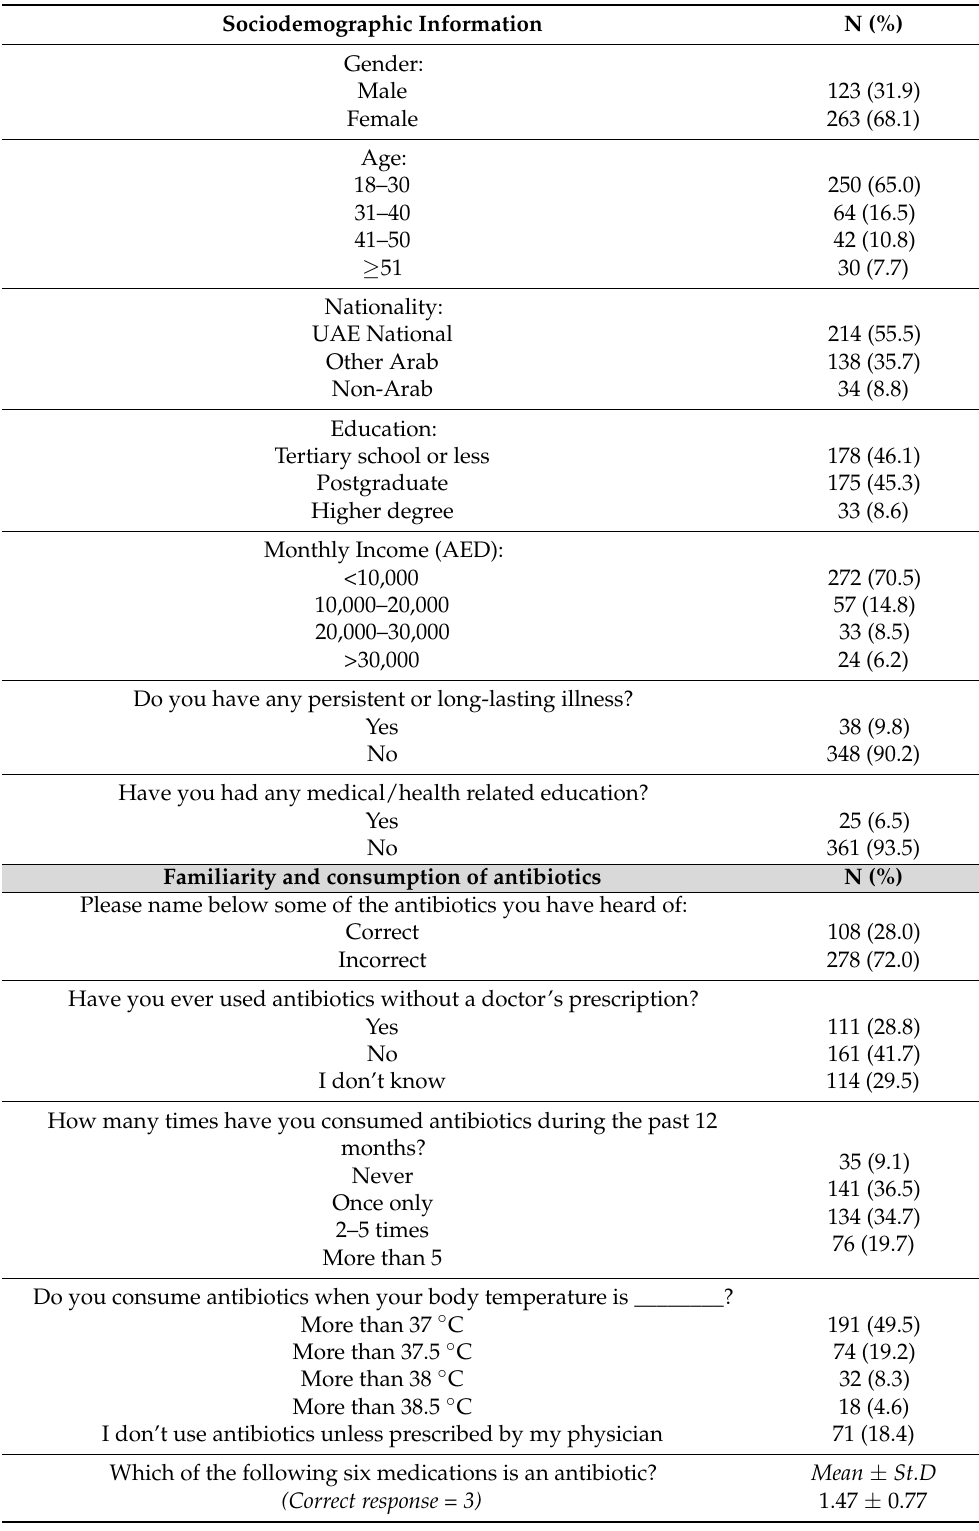
Table 1. Sociodemographics and antibiotic familiarity and consumption of participants, N =